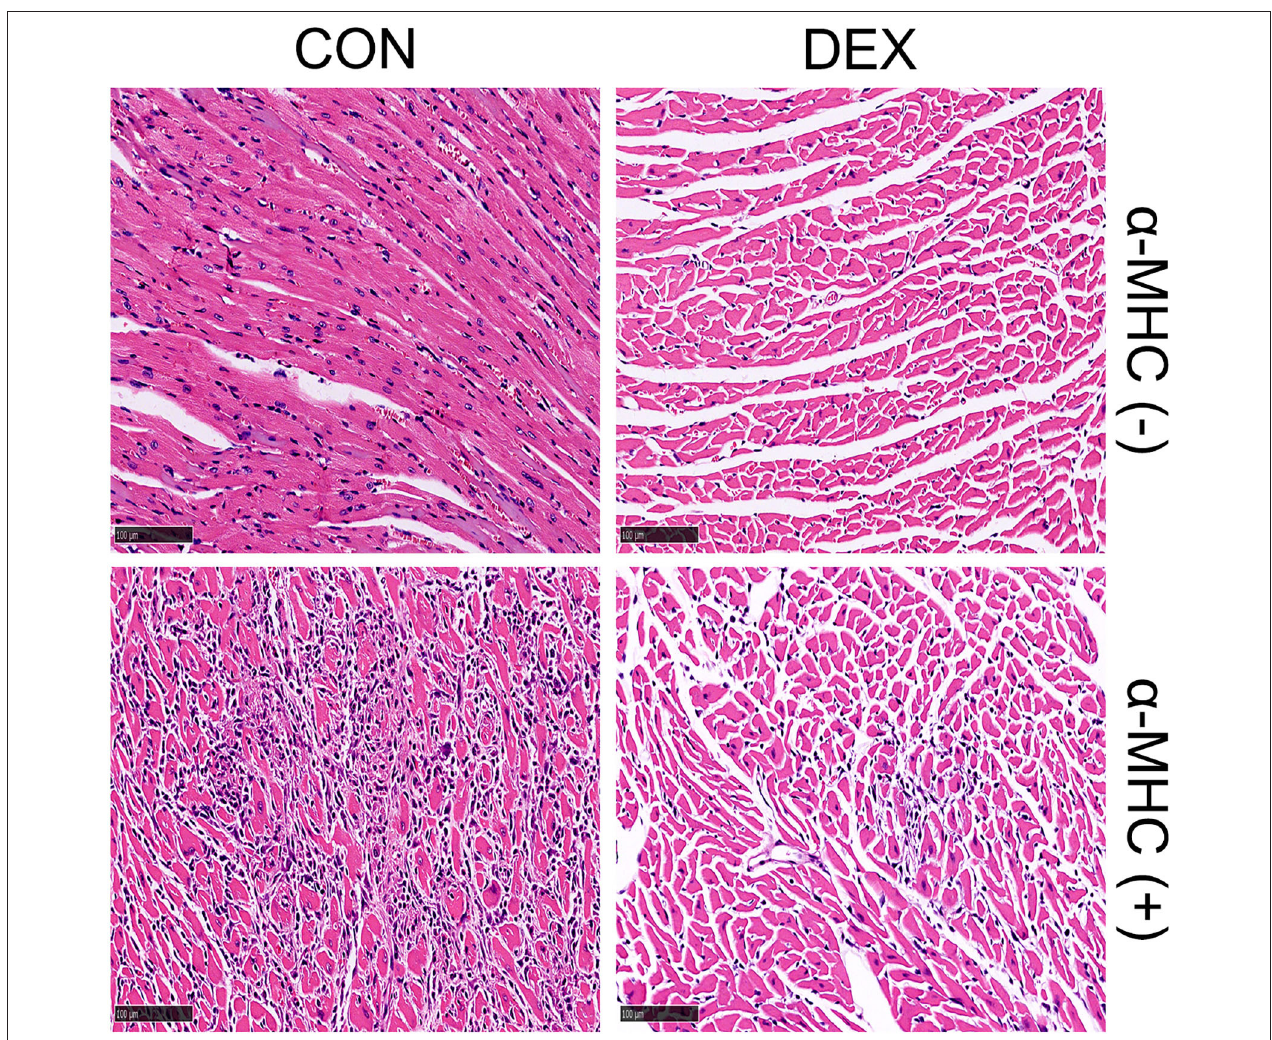
FIGURE 5 | Representative heart sections of dexamethasone-treated autoimmune myocarditis induced by α -MHC immunization ( α -MHC + ). Establishment and treatment methods: in 0 and 7 days, respectively, 300 µ g α -MHC (Ac-RSLKLMATLFSTYASADR-OH) was subcutaneously injected into BALB/C mice. Then, 0.75 mg/kg/day dexamethasone was given for intervention on the 16th to 20th day via intraperitoneal injection. The mice were sacrificed and their hearts were fixed with formalin for H&E staining on day